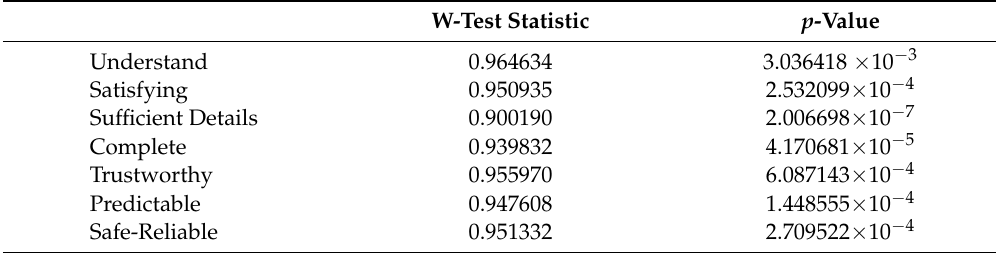
Table A5. Shapiro-Wilk test results for “Why” explanations.